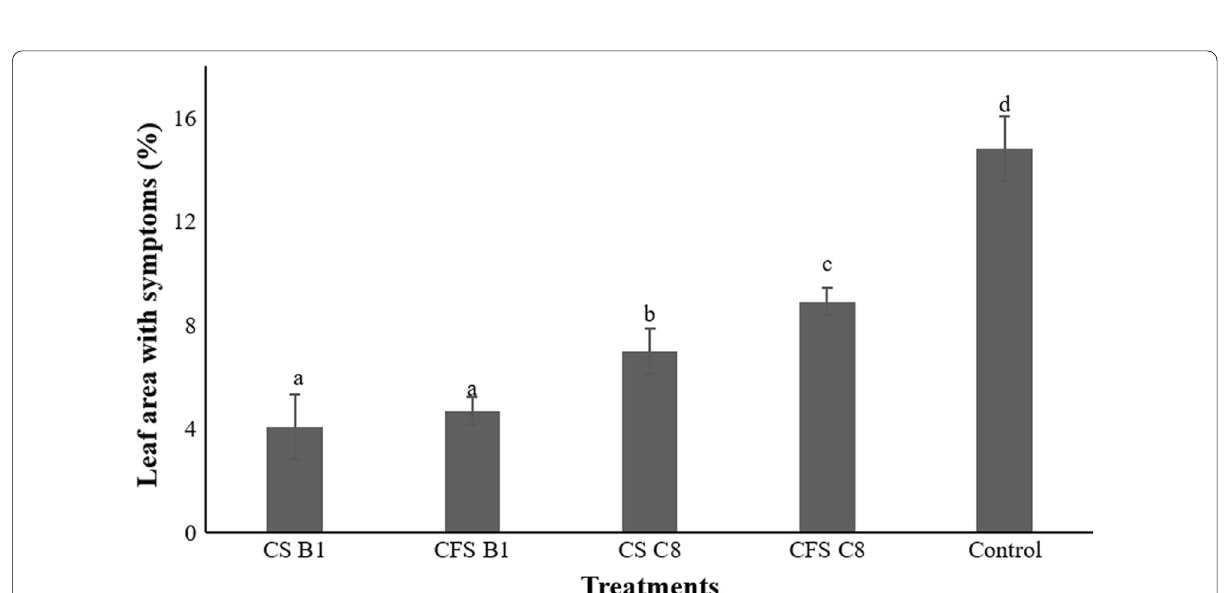
Fig. 8 Percentage of the symptomatic area on the treated leaf after 4 weeks of experiments. Different letters on each histogram indicated any difference in the percentage of symptomatic area among treatments ( p <